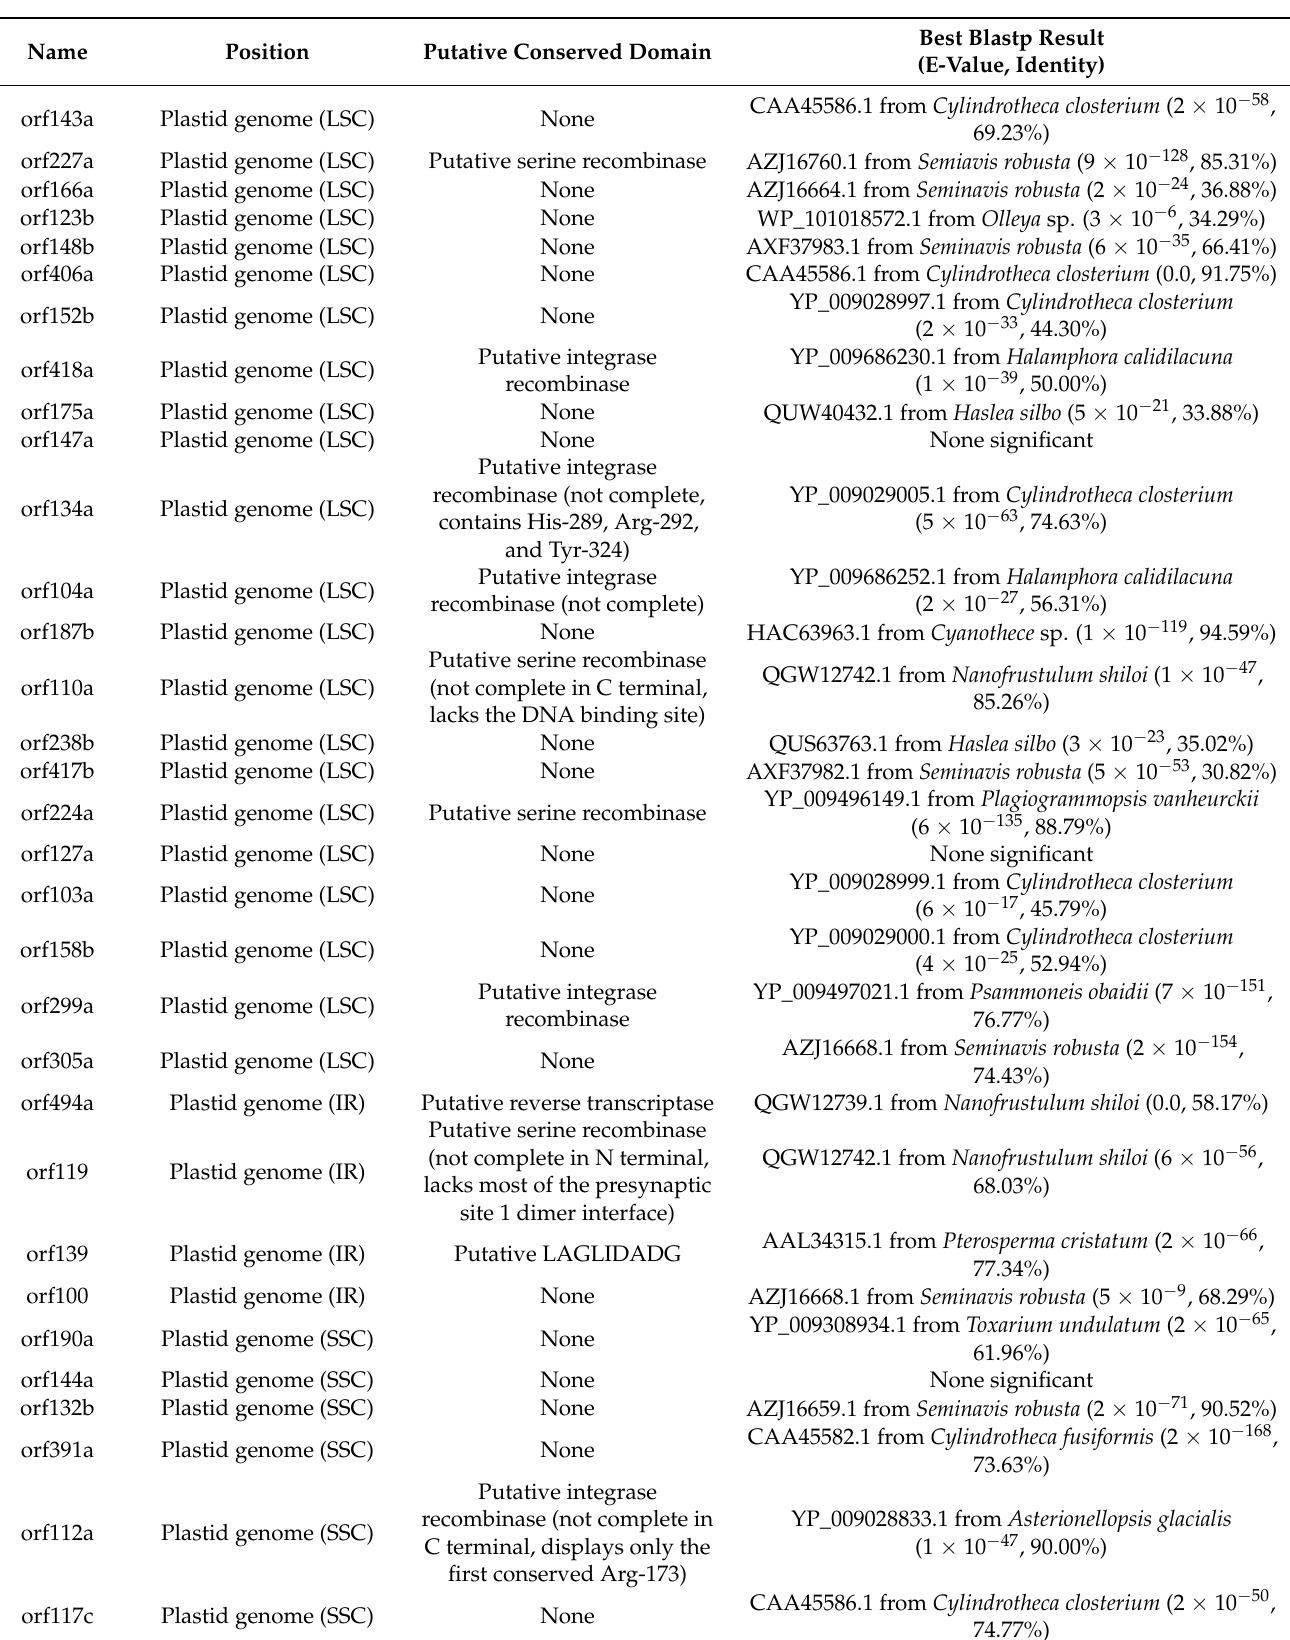
Table 1. List of the various ORF found in the mitochondrial and plastid genomes of Schizostauron trachyderma , with the name, position, putative conserved domains, and best blastp